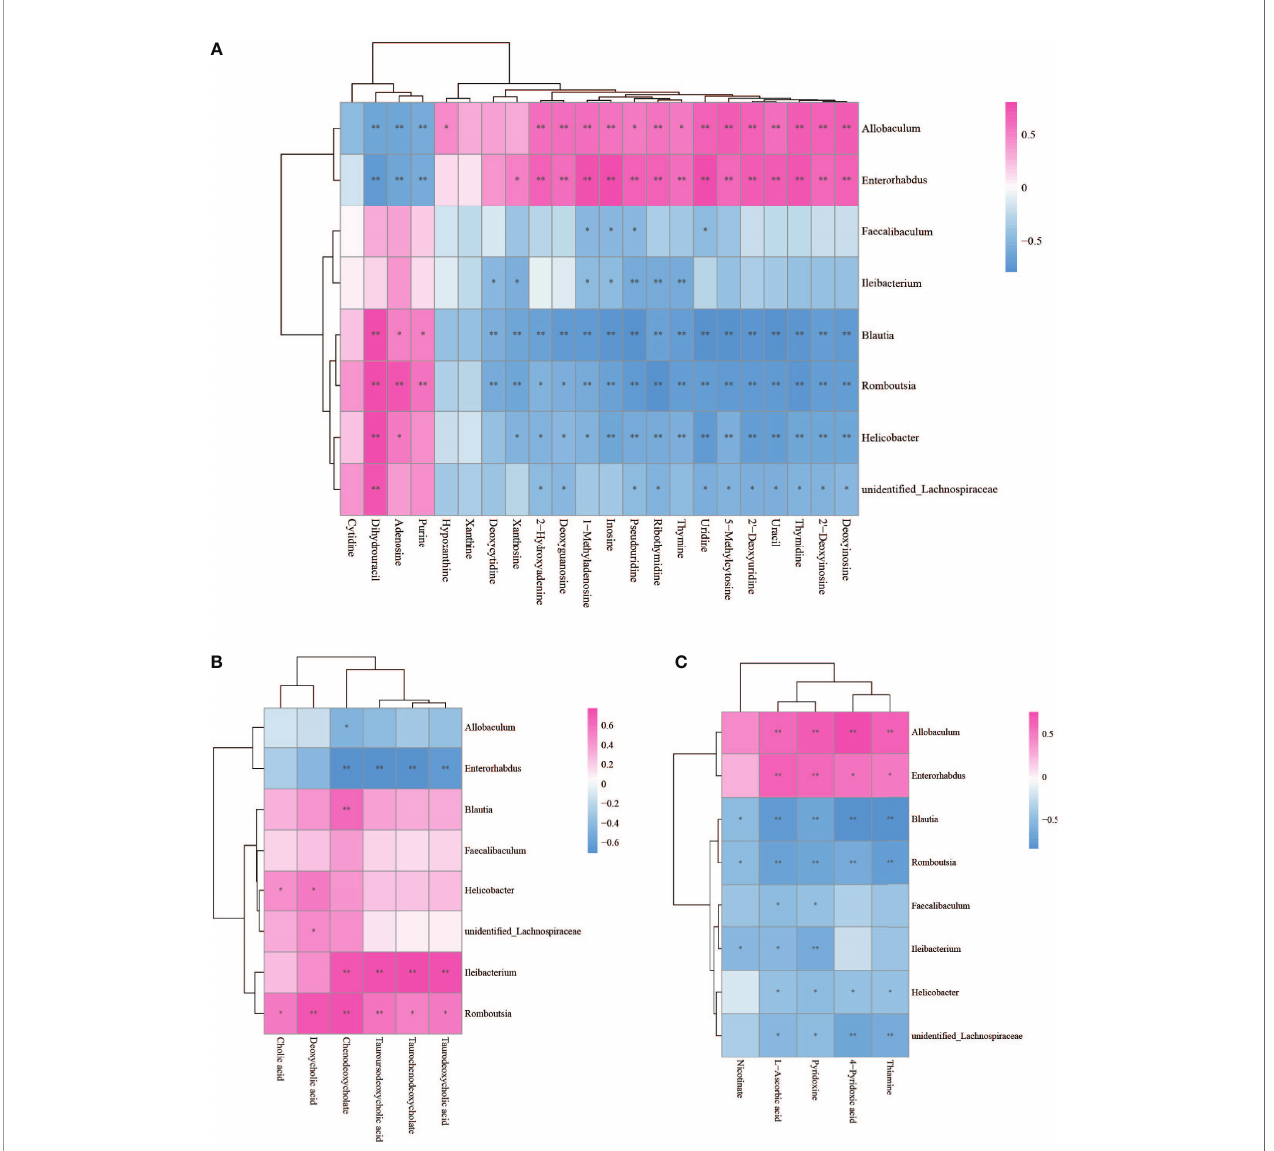
FIGURE 8 | Spearman correlations between signi fi cant bacteria based on LEfSe and differential nucleotide (A) , bile acid (B) , vitamin (C) are presented in the form of a correlation coef fi cient matrix heat map. The correlation coef fi cient r is shown in color. r >0, positive correlation, shown in red; r < 0 represents a negative correlation, shown in blue, and the darker the color, the stronger the correlation. “ * ” indicated p-value < 0.05, “ ** ” indicated p-value <